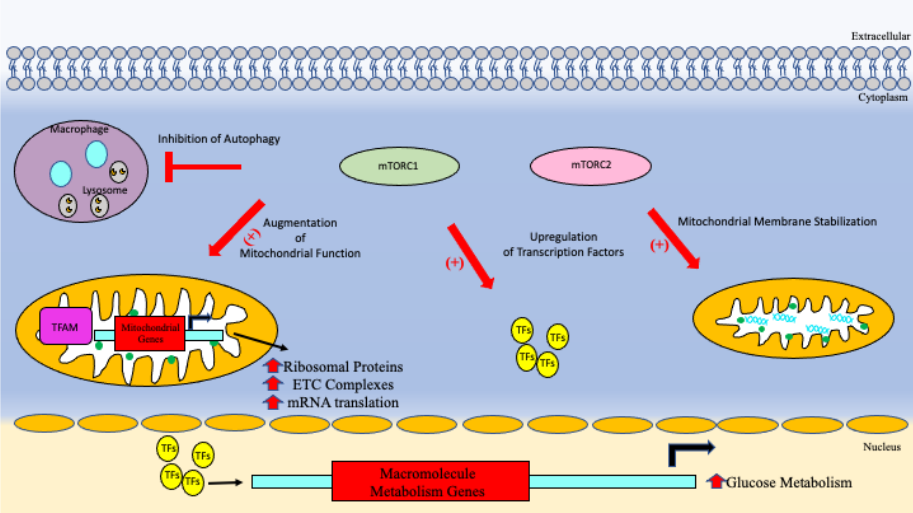
Figure 4. mTORC1 and mTORC2 pathways on autophagy, mitochondria, cell growth, genetics, and mitochondrial membrane stabilization.